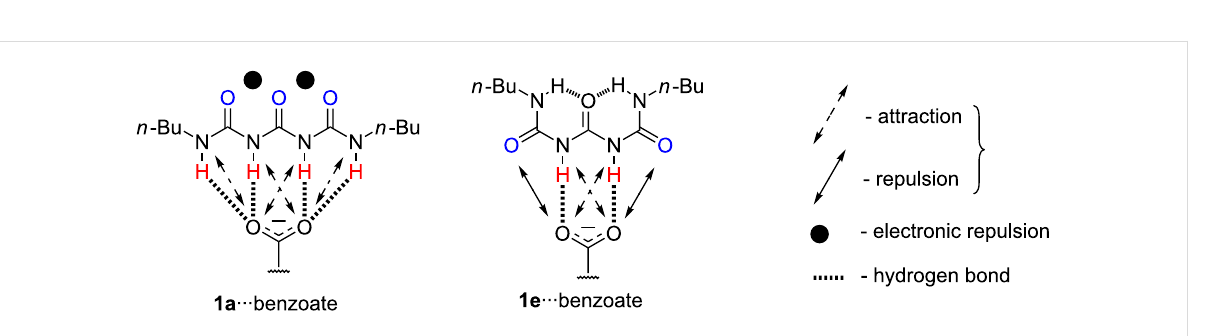
complex (Figure 3) are: a) multiple hydrogen bonding, b) secondary attractive or repulsive interactions and c) elec- tronic